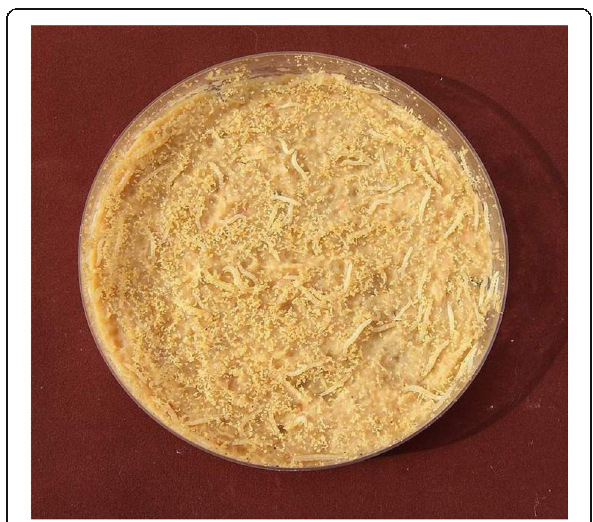
Fig. 1. Larvae of S. recurvalis reared on semi-synthetic diet showing the silky web